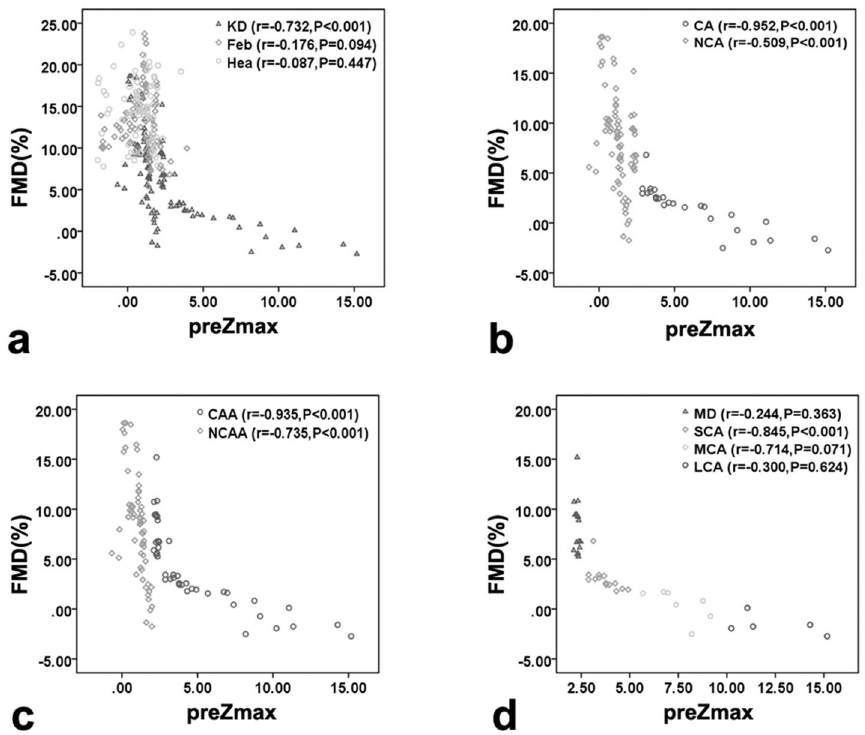
Figure 4. Correlation between flow-mediated dilation (FMD) and pretreatment maximum coronary artery Z-score (preZmax) in groups. KD Kawasaki disease; Feb febrile (controls); Hea healthy (controls); CA coronary aneurysm; NCA no coronary aneurysm; CAA coronary artery abnormality; NCAA no coronary artery abnormality; MD mild dilation; SCA small coronary aneurysm; MCA middle coronary aneurysm; LCA large coronary aneurysm. Scatter plots showing ( a ) correlation between FMD and preZmax in the KD, febrile and healthy groups; ( b ) correlation between FMD and preZmax in the CA and NCA groups; ( c ) correlation between FMD and preZmax in the CAA and NCAA groups; ( d ) correlation between FMD and preZmax in the CAA subgroups.